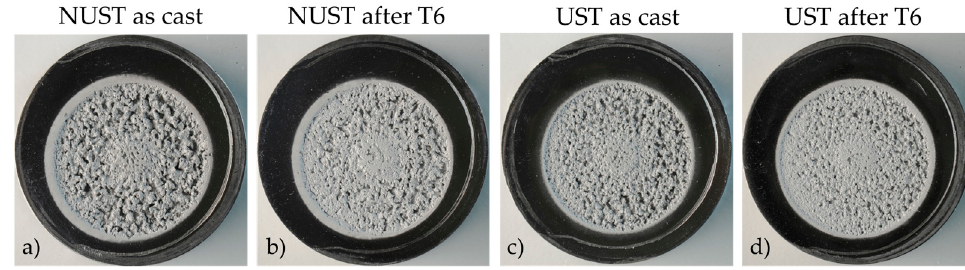
Figure 12. Surface topographies of the damaged areas of conventionally as-cast ( a ) before and ( b ) after T6, semi-solid in ( c ) as-cast and ( d ) after T6 [111]. T6, semi-solid in ( c ) as-cast and ( d ) after T6 [111].